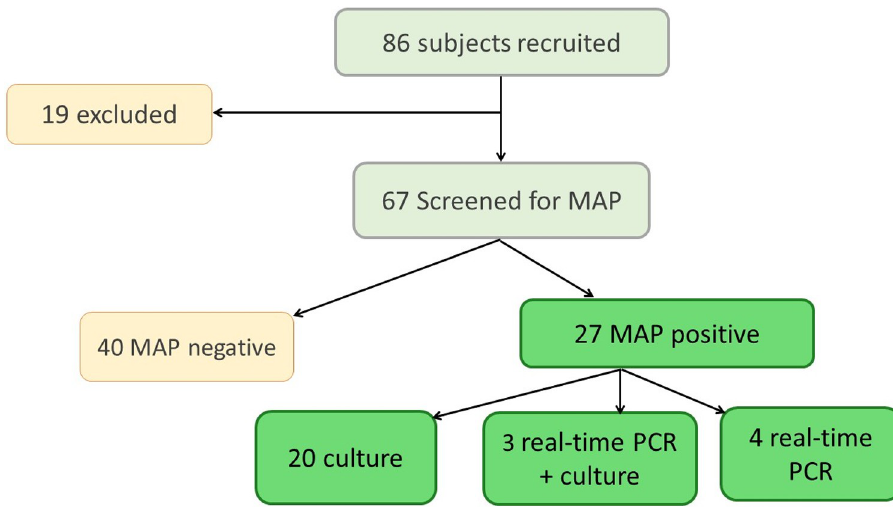
Fig 2. MAP positivity of tested samples of patients with gastrointestinal diseases.